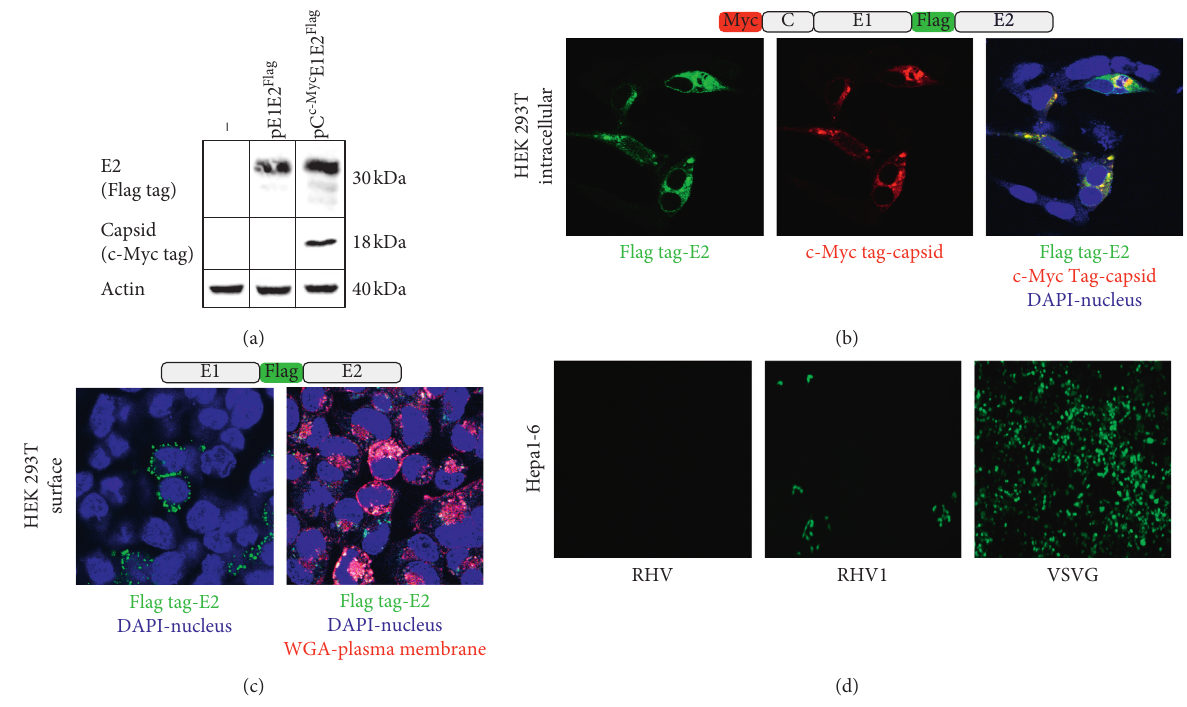
Figure 4: Expression of RHV envelope proteins. Schematic of the RHV1 envelope expression vector and western blot of cell lysate at 48h.p.t. from transfected HEK 293T (a) Intracellular immunofluorescence of 293Tcells at 48h.p.t. with RHV1 envelope expression vector, stained with flag tag in green, c-Myc tag in red, and combined with DAPI stain (b) Extracellular immunofluorescence for E2 by flag tag stain (green) and combined with WGA (red) and DAPI (blue) from 293Tat 48h.p.t. with RHV1 envelope expression vector, and images represent one slice from z-stack (c) GFP-lentivirus vector pseudotyped with RHV or RHV1 envelope proteins or VSVG were incubated on Hepa1-6 cells; GFP positive cells indicate transduction